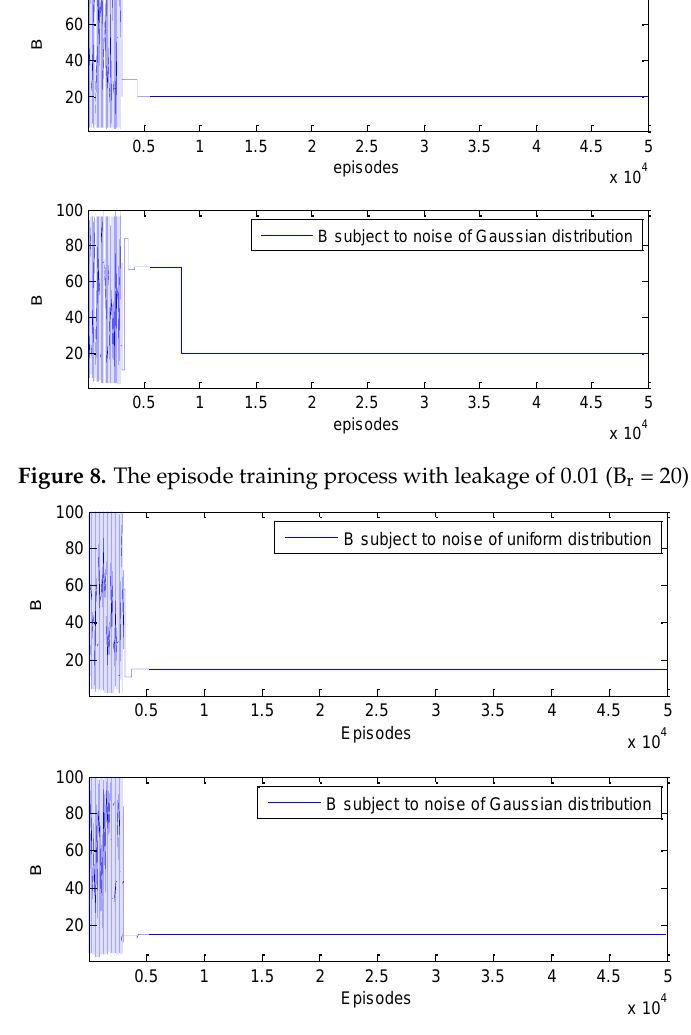
Figure 9. The episode training process with leakage of 0.02 ( B r = 15).